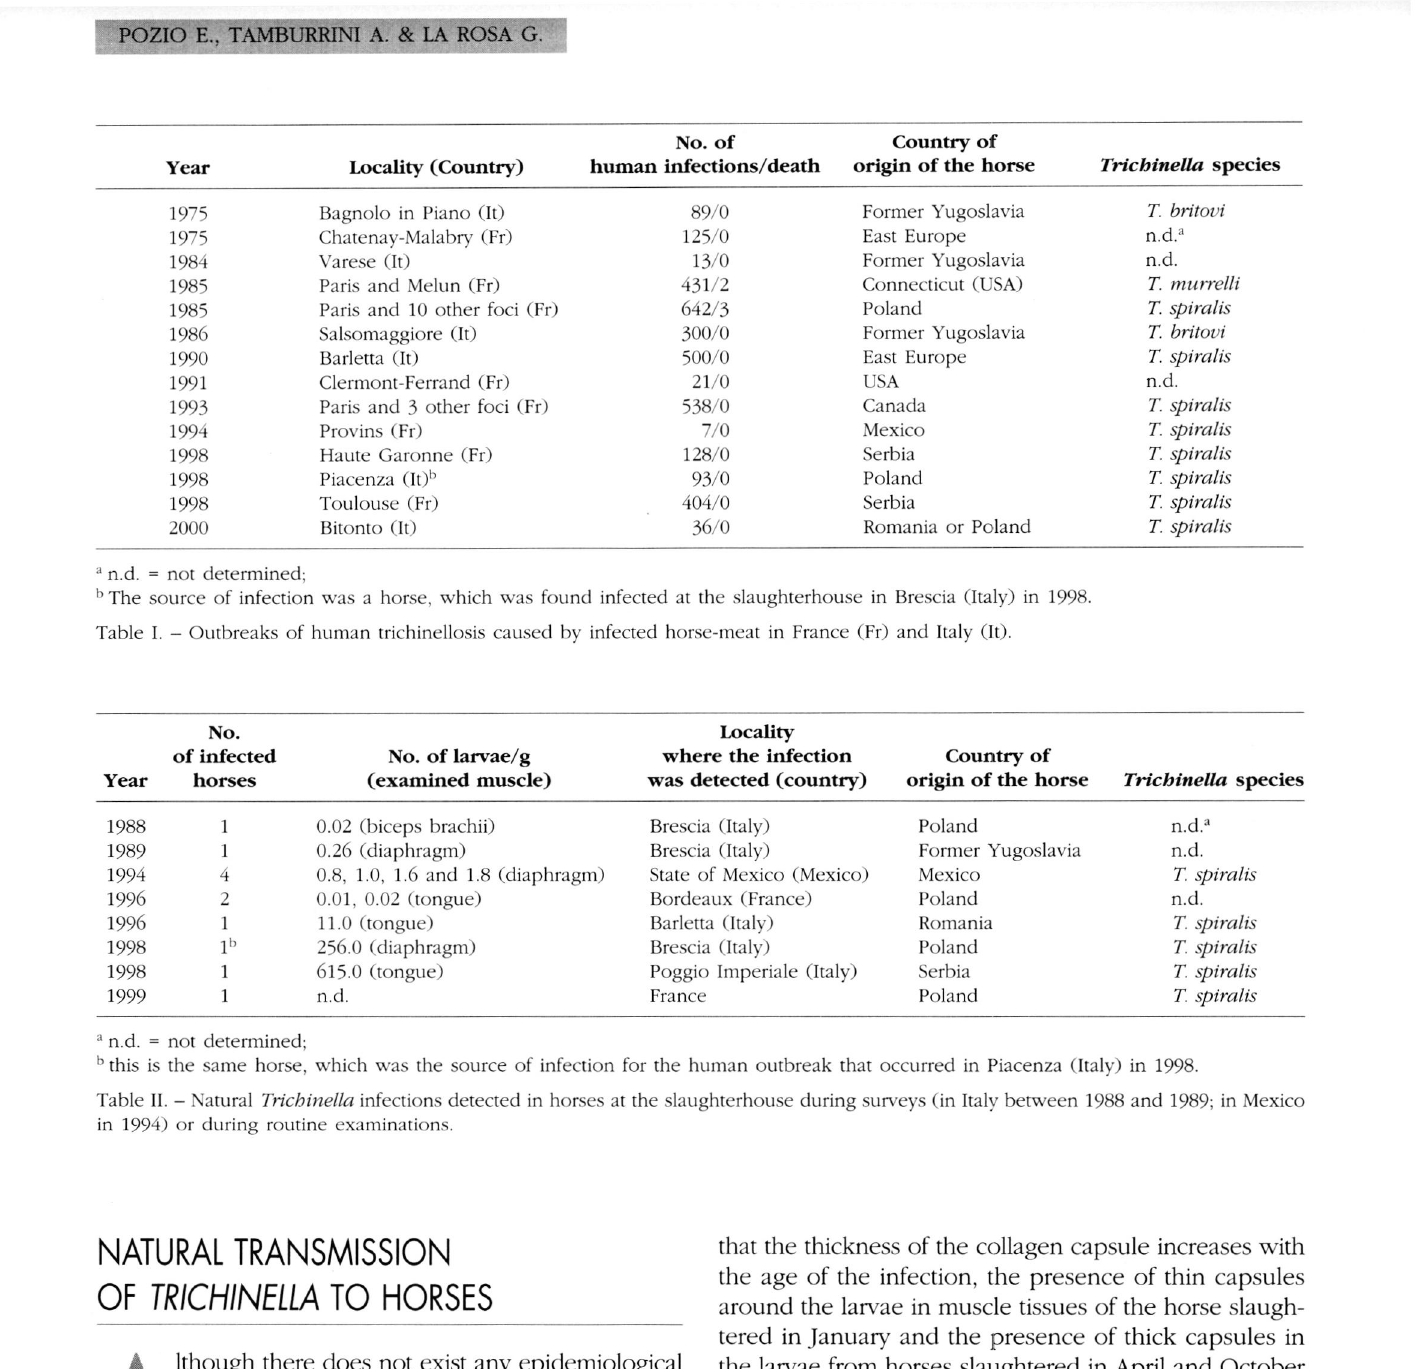
Table I. - Outbreaks of human trichinellosis caused by infected horse-meat in France (Fr) and Italy